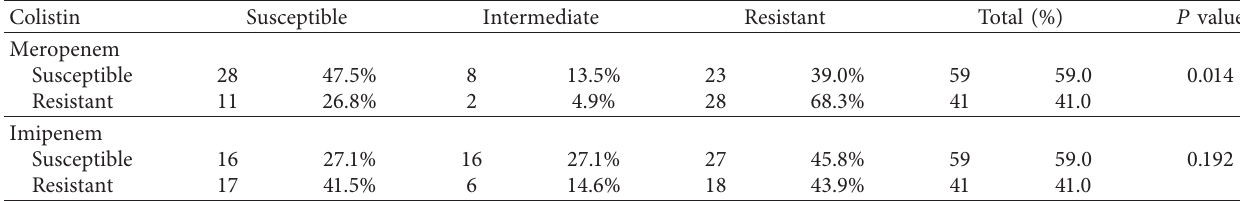
Table 6: Colistin resistance among carbapenem-resistant Enterobacteriaceae